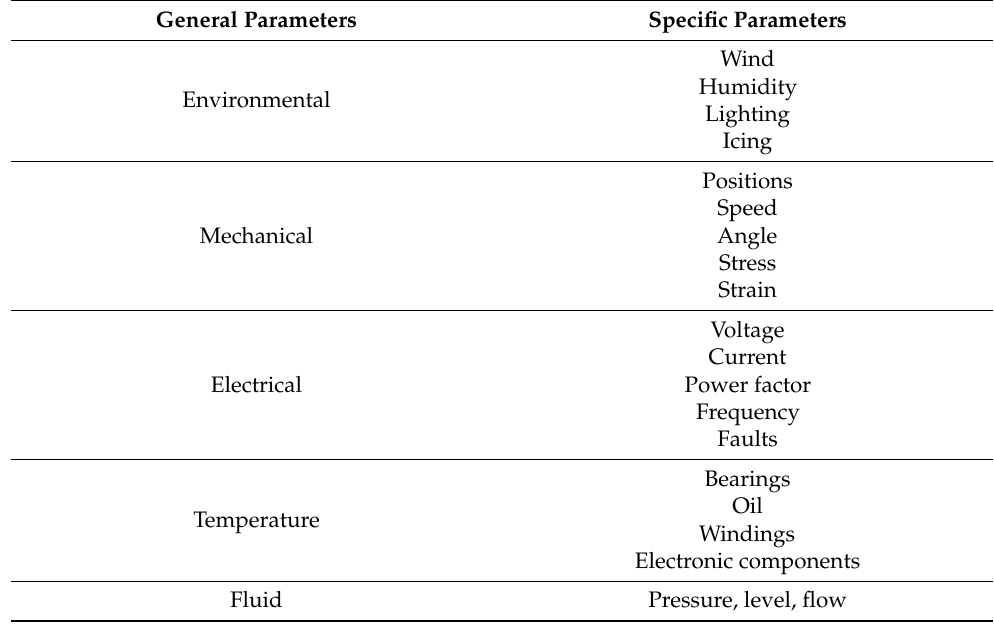
Table 6. Factors to be monitored in real-time wind energy (a survey of cyber-physical advances). General